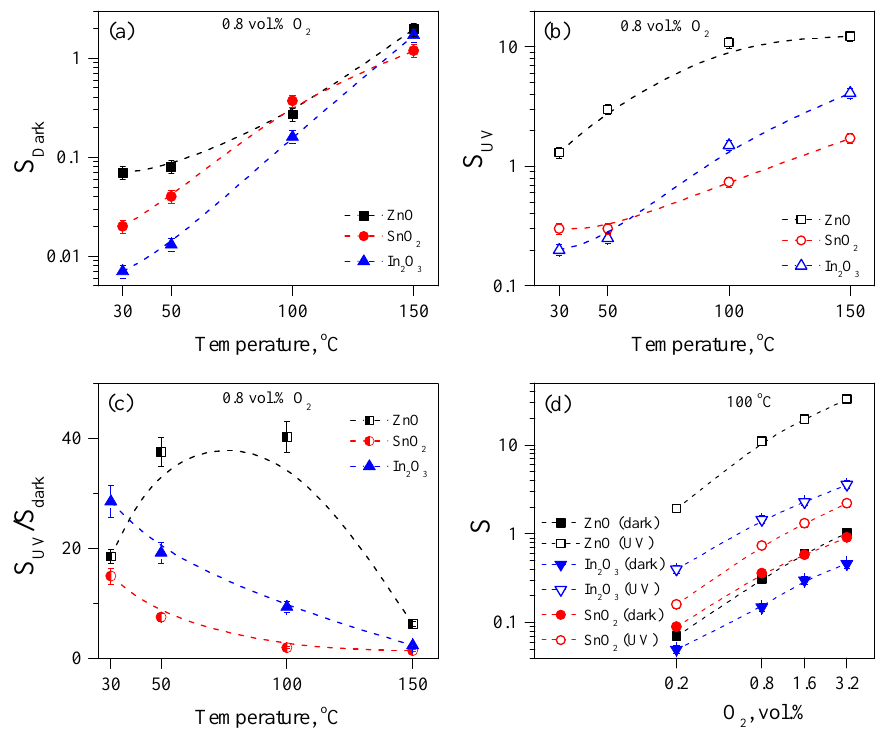
Figure 8. ( a ) Temperature dependence of the sensor signal to 0.8 vol.% oxygen on temperature in the dark (S dark ); ( b ) temperature dependence of sensor signal to 0.8 vol% oxygen under UV (S UV ); ( c ) temperature dependence of the S UV /S dark ratio to 0.8 vol.% oxygen; ( d ) dependence of the sensor signal on the oxygen concentration at 100 ◦ C, both in the dark and under UV